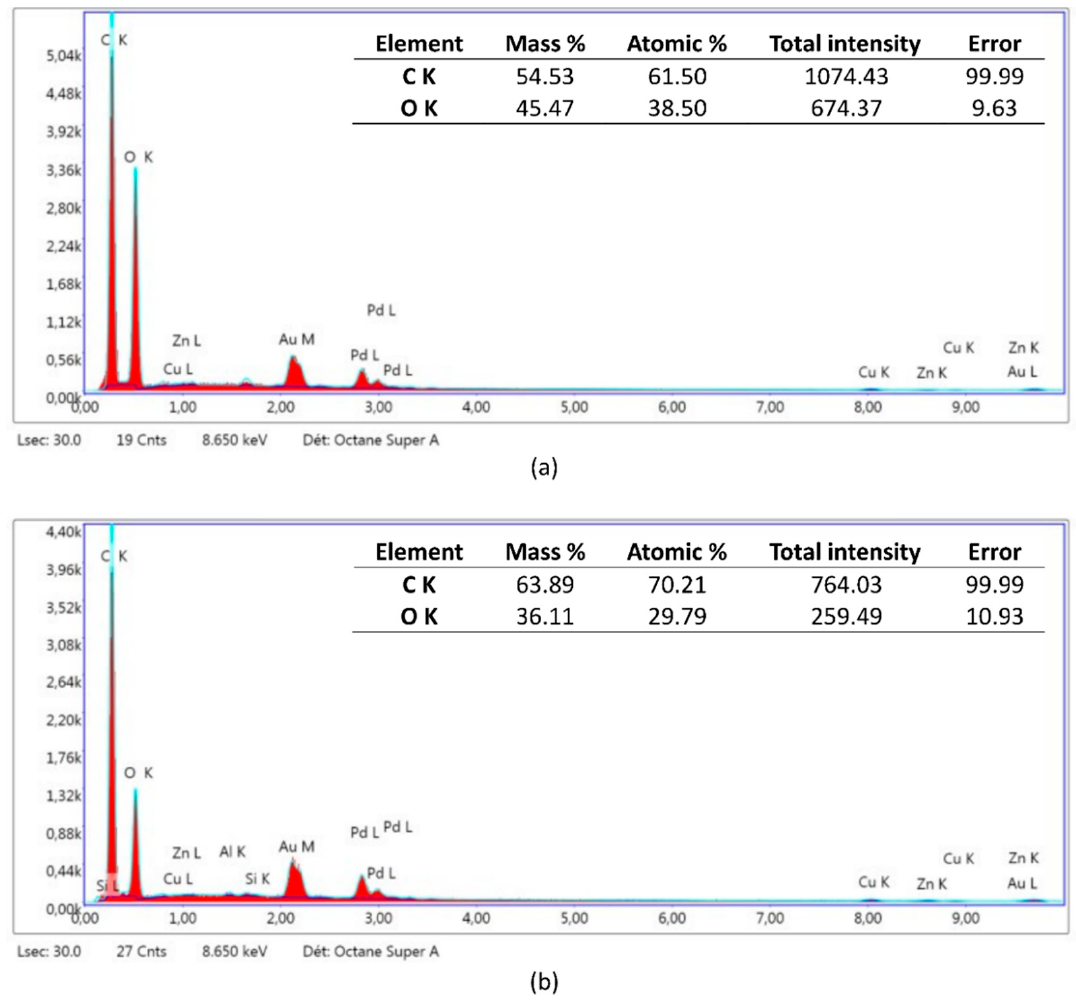
Figure 9. Energy dispersive spectroscopy (EDS) spectra for the maple fibers: ( a ) untreated and ( b ) treated.